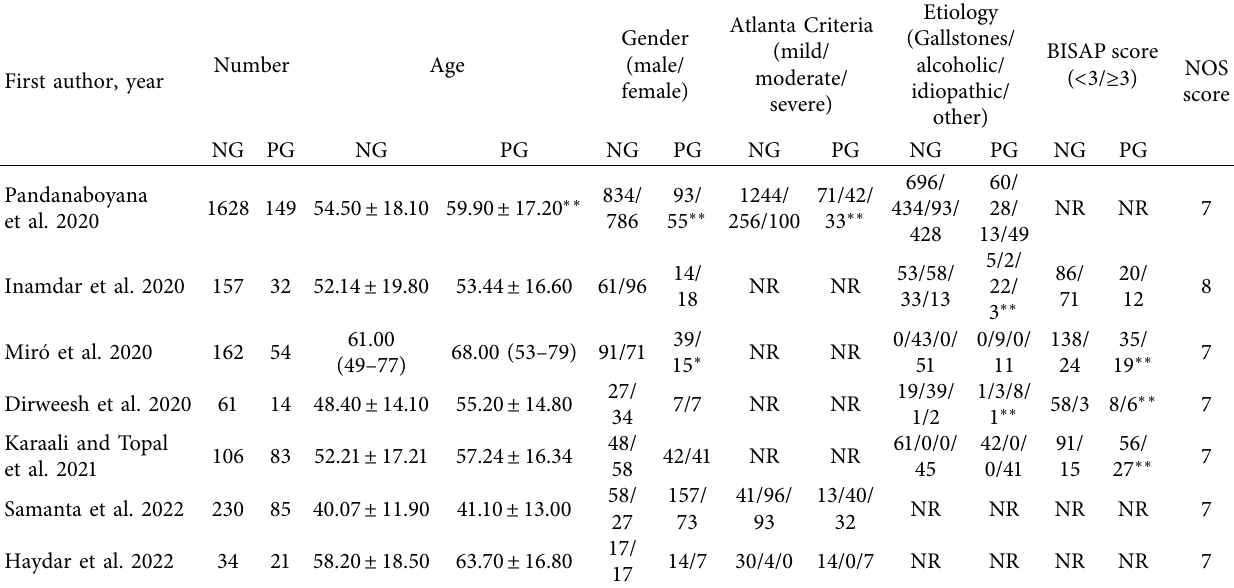
Table 1: Baseline characteristics and demographics of patients included.